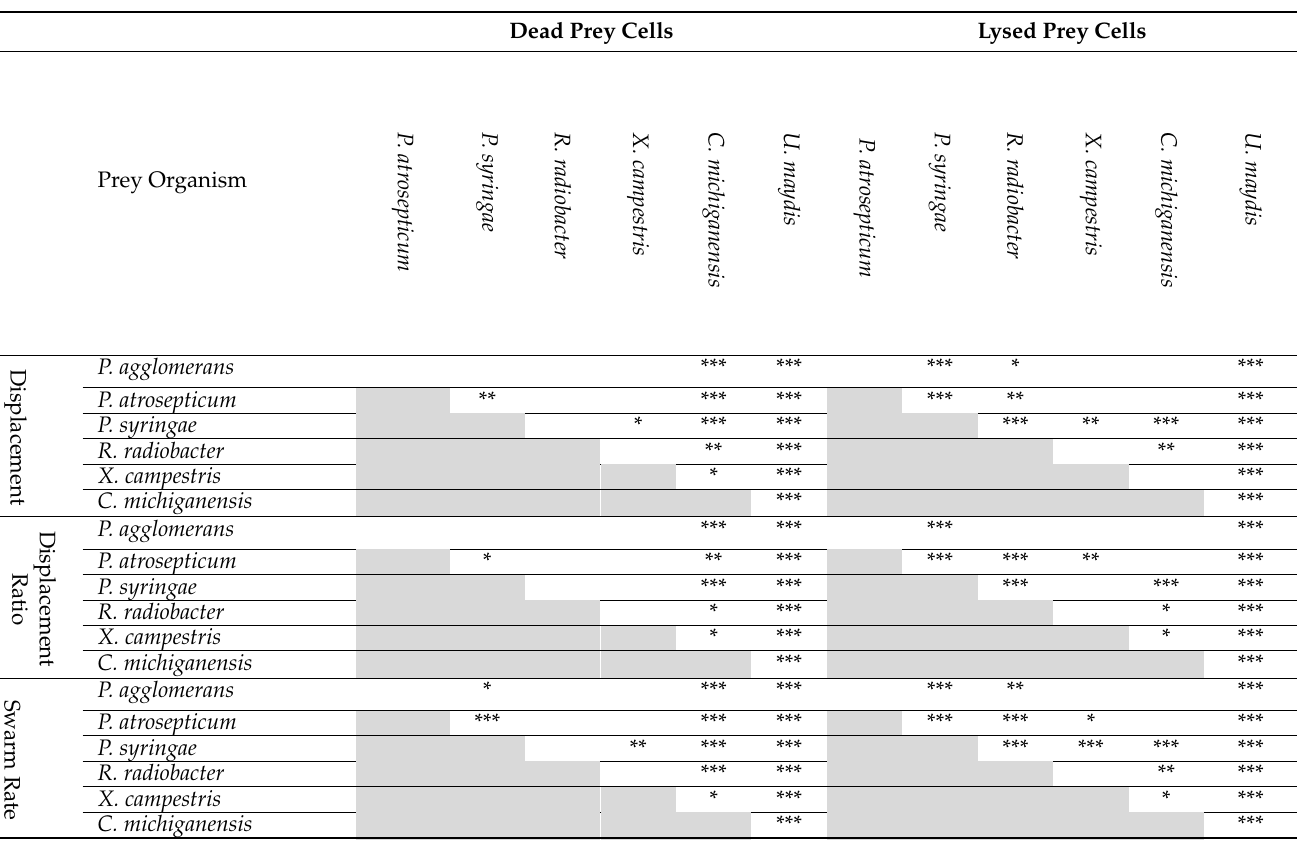
Table 4. Pairwise comparisons of myxobacterial predation metrics for pairs of prey organisms, when provided as dead or lysed prey cells. Asterisks indicate statistical significance between prey